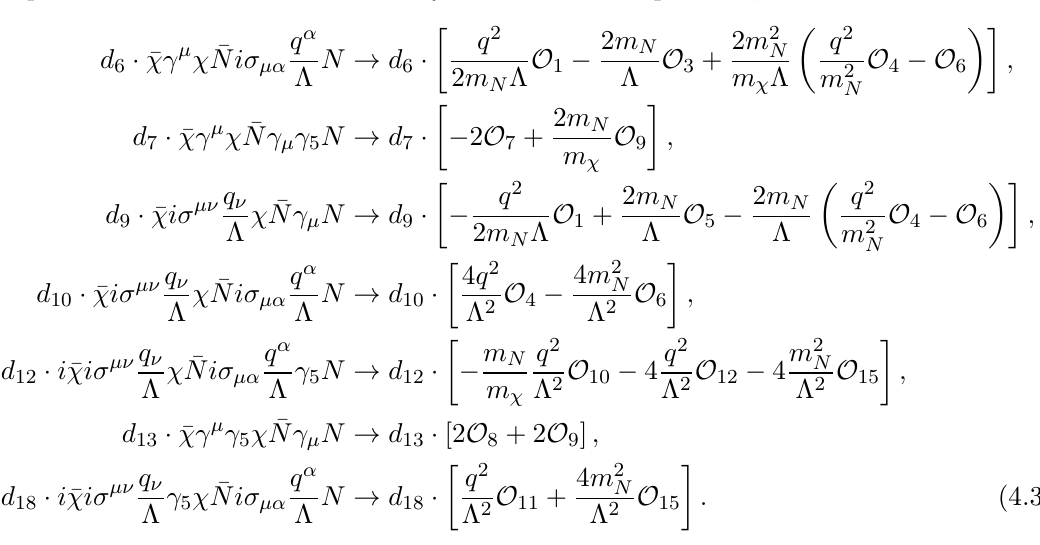
Figure 5 . The predicted ratio of the coe(cid:14)cient c n line) and the maximum cancellation at the 95% CL (red